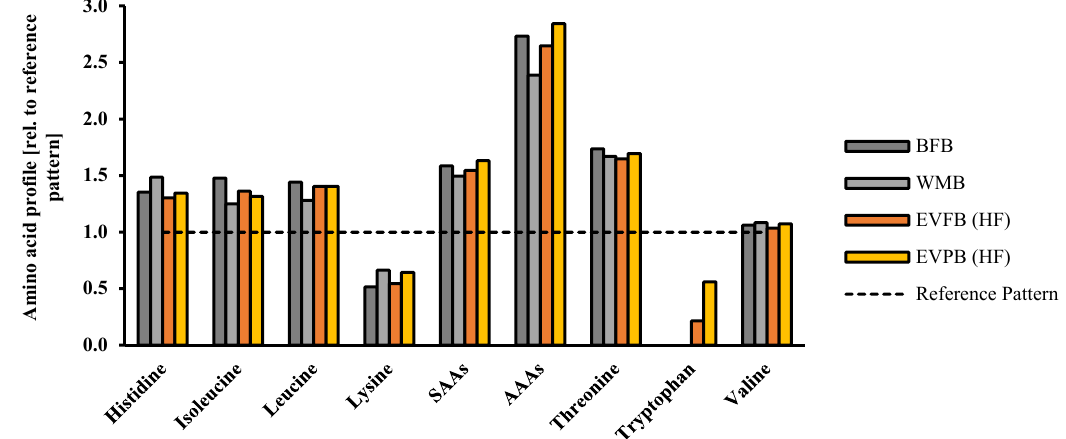
Figure 6. Profile of indispensable amino acids of the final breads baker’s flour control (BFB), wholemeal flour control (WMB), high in fibre bread including EverVita FIBRA (EVFB (HF)) and high in fibre bread with EverVita PRO addition (EVPB (HF)). The values are expressed relative to the requirement pattern established by the World Health Organisation [29].